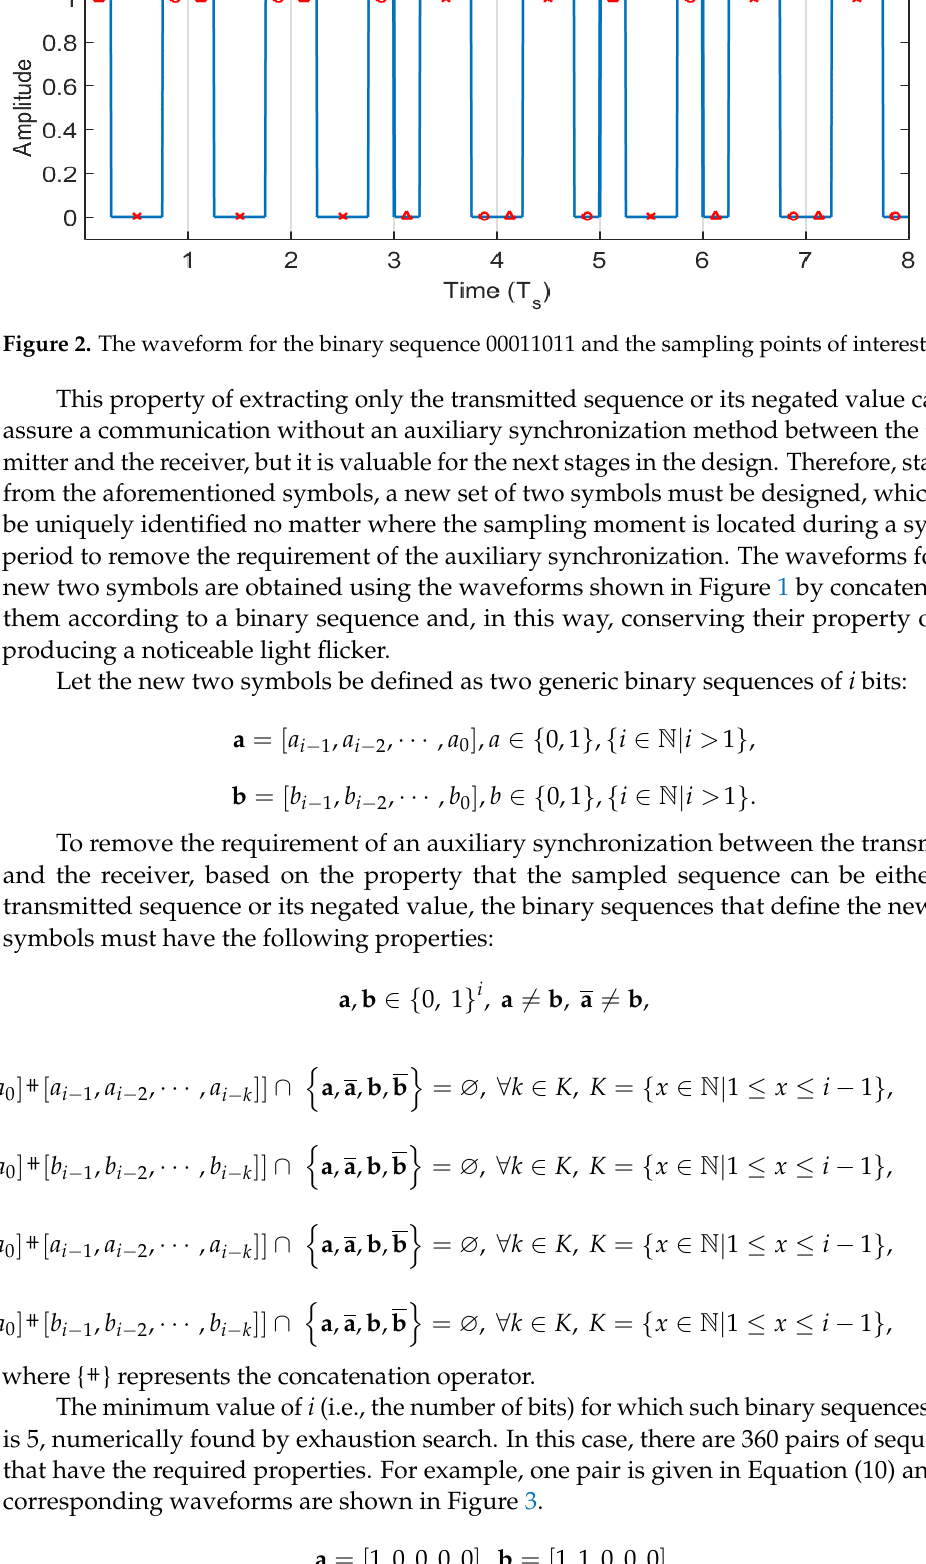
Figure 2. The waveform for the binary sequence 00011011 and the sampling points of interest.